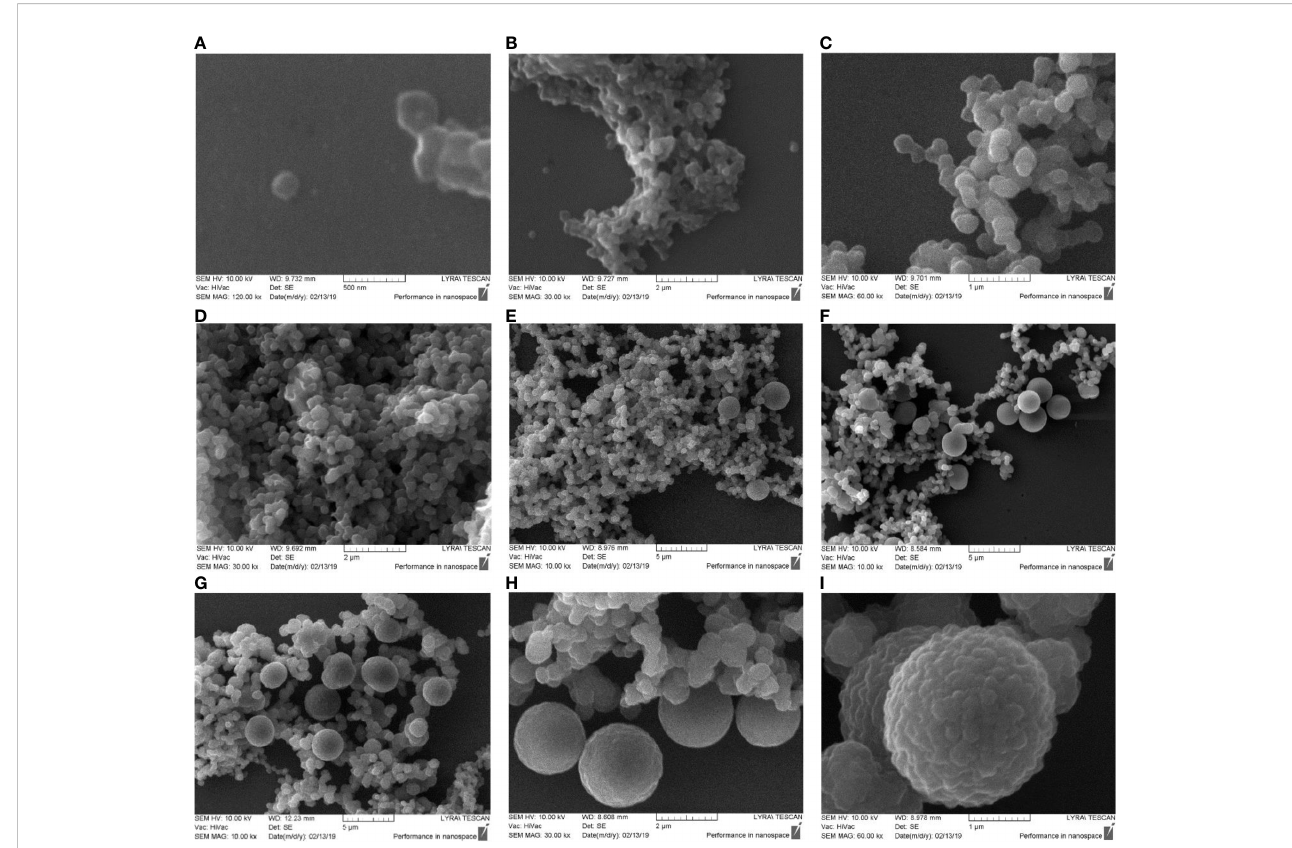
FIGURE 4 SEM images of cultured blood microbiota. Blood samples were lysed, 0.22 µm fi ltered and cultured for 7 hours. (A, B) SEM analysis of cultured blood for 1 hour. (C – E) cultures at 2 – 4 hours. (F – H) cultures at 5 – 7 hours. (I) SEM morphology of big “ mother ” cell after 7 hours of